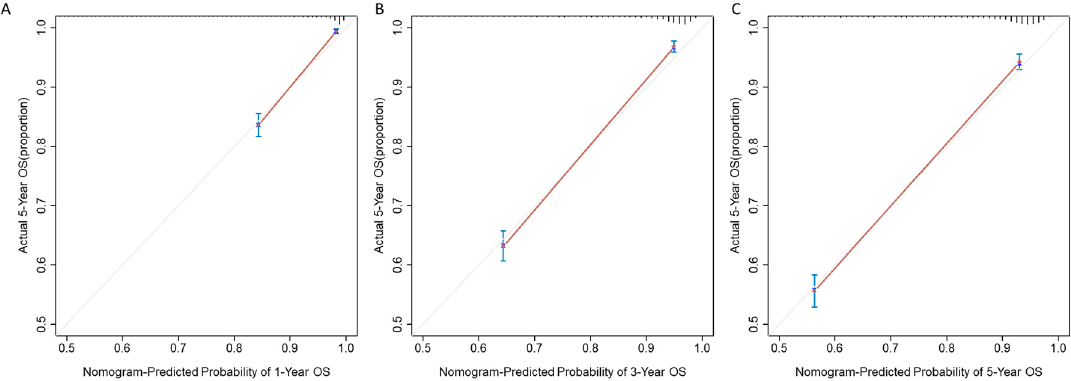
Figure 4. Calibration curve of the nomogram model at the timepoint of ( A ) 1 year, ( B ) 3 years, and ( C ) 5 years. Table 3. Model performance in the testing